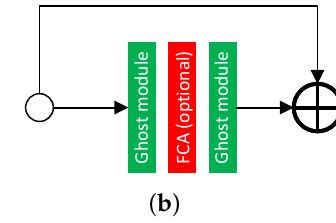
Figure 3. The schematic diagram of the Ghost module ( a ) and Ghost bottleneck ( b ). The Ghost module partially uses cheap operations to generate pseudo feature maps, which is more computation efficient than traditional convolution. The Ghost bottleneck is a residual unit [25] built up by two ghost modules and an optional squeeze-and-excitation block. Batch normalizations and activations are omitted for